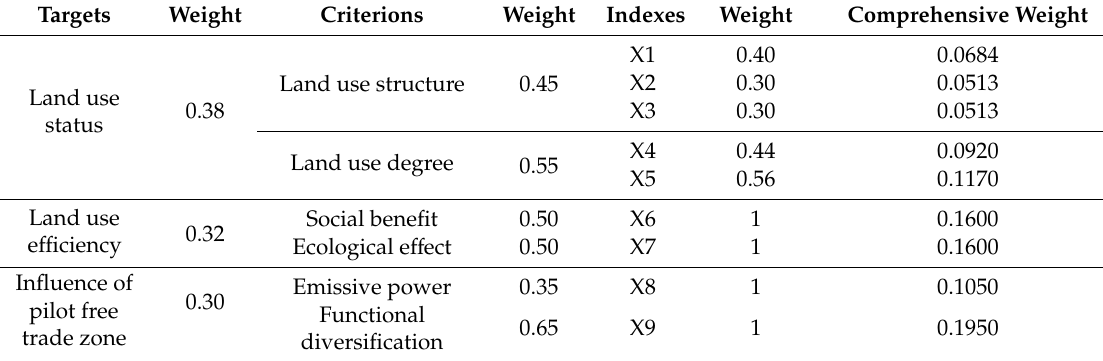
Table 5. Evaluation index weights based on the Delphi